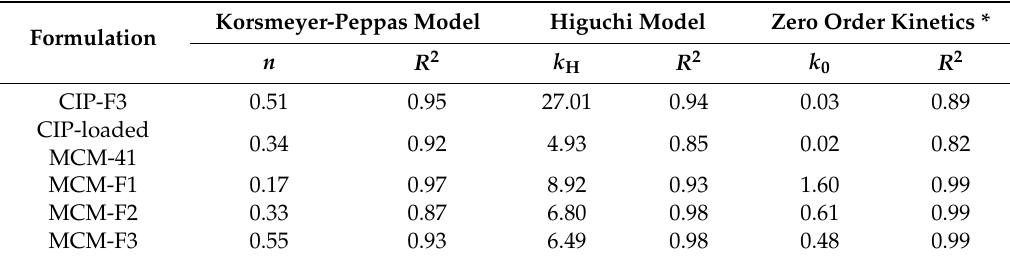
Table 4. The kinetic parameters of fitted experimental data for MCM-F1, MCM-F2, MCM-F3, CIP-F3 solid films and CIP-loaded